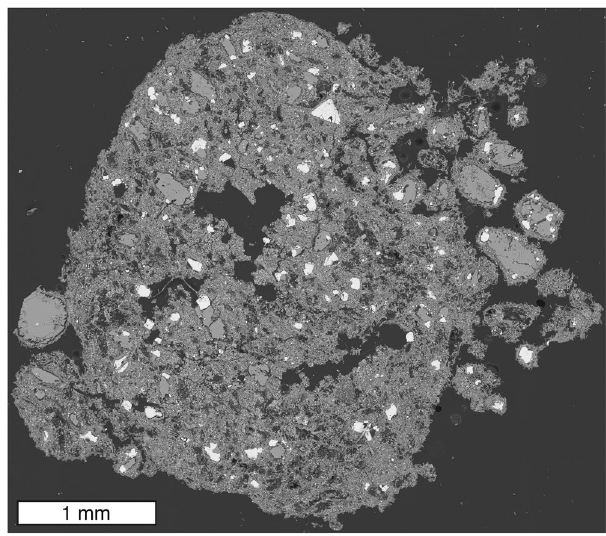
Fig. 6 Backscatter scanning electron microscopy image of a juvenile pyroclast (sometimes referred to as a magmaclast in the kimberlite literature 85 ). This pyroclast was recovered from the same fallout deposit as shown in Fig. 1. Multiple droplets are observed adhering to the pyroclast, indicating that the processes of agglutination are widespread and not unique to the olivine cored